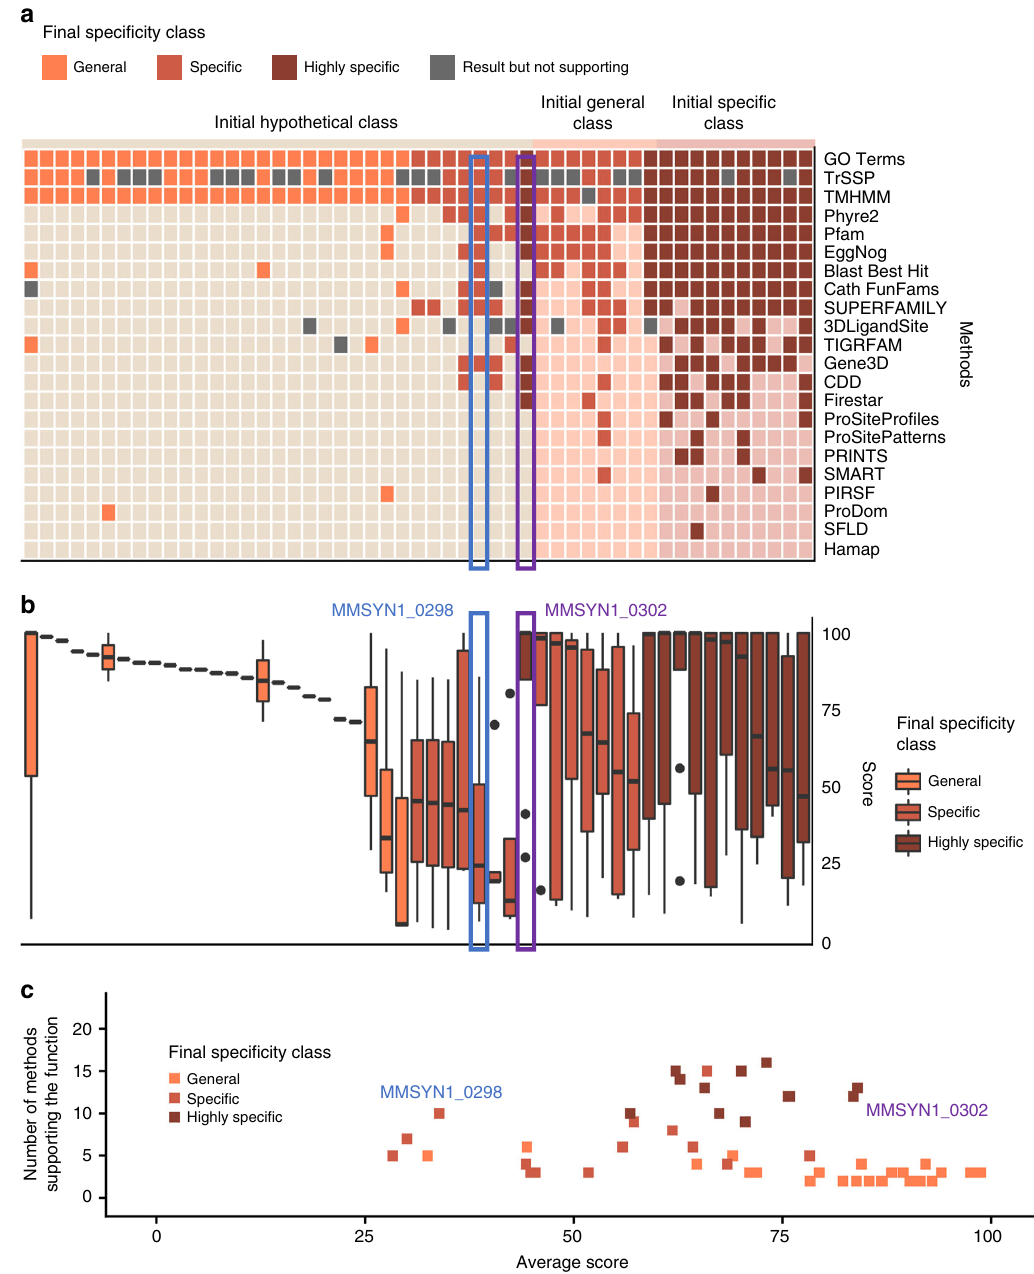
Fig. 5 Proteins assigned new functions. This fi gure shows the 51 proteins where the speci fi city class was increased. Results for each fi nal speci fi city class are represented by a different colour: orange for the General speci fi city class, light brown – Speci fi c and dark brown – Highly speci fi c. a Each column represents a protein in the minimal genome and the squares show the methods that made predictions (darker colours indicate support of the fi nal prediction), grey squares indicate predictions that did not support the function, light squares indicate that a method did not make a prediction. Proteins are grouped by their initial speci fi city class (Hypothetical, General, Speci fi c and Highly speci fi c) and then by their fi nal speci fi city class. b Boxplot demonstrating the distribution of the scores across proteins. Proteins grouped by their initial speci fi city class and then by their fi nal speci fi city class. Horizontal lines represent the median, the lower and upper hinge show respectively fi rst quartile and third quartile, and lower and upper whisker include scores from fi rst quartile to (distance between the fi rst and third quartile)× 1.5 (for lower whisker) and from third quartile to (distance between the fi rst and third quartile)× 1.5 (for upper whisker). Any scores outside of these intervals are shown as points. c The number of methods supporting the function and the average score. Each point represents a